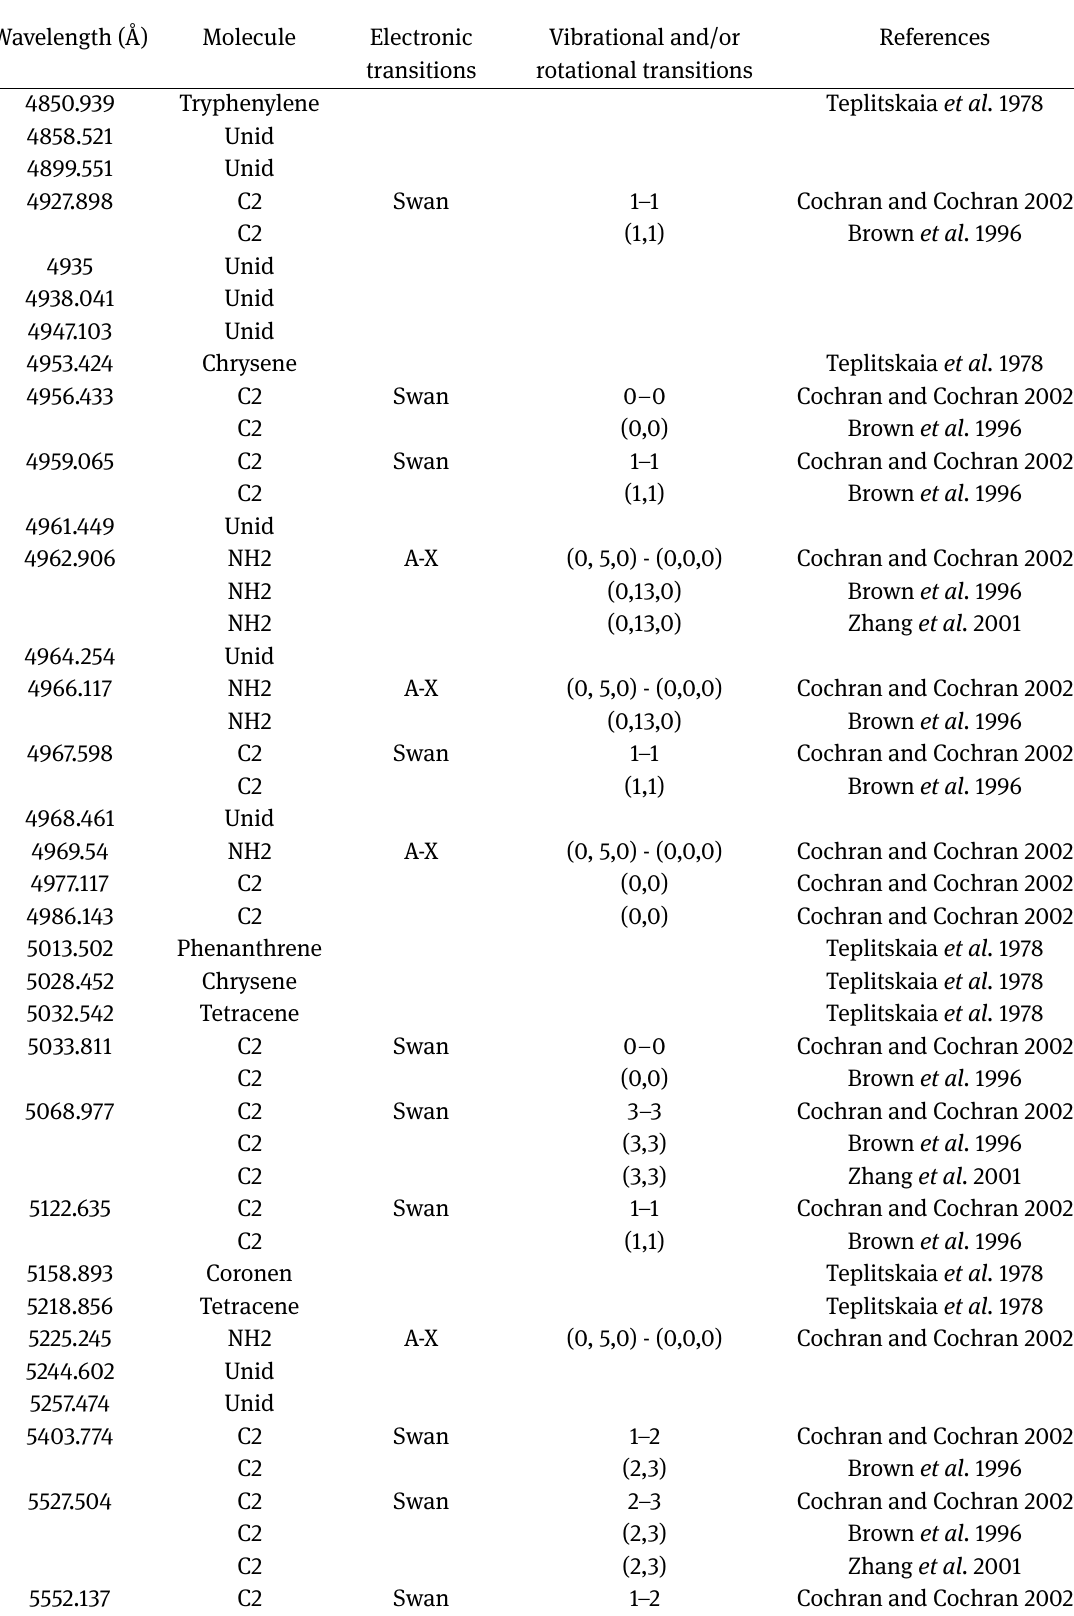
Table 2. Identified molecules in the matter of C/2001 Q4 (NEAT). Wavelength (Å) Molecule Electronic